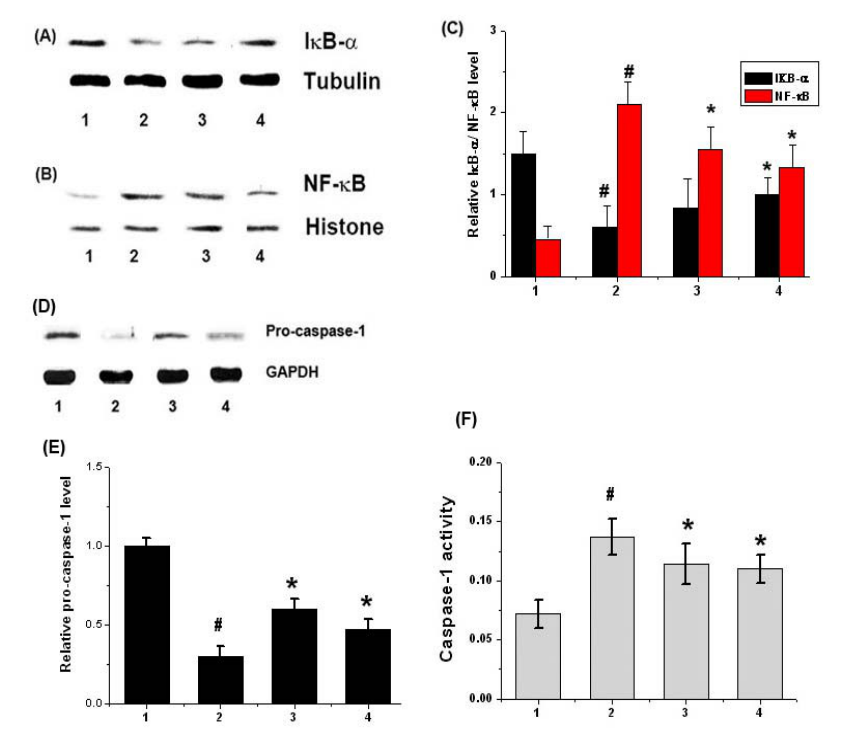
Figure 5. Effect of chrysophanol on degradation of I κ B- α and activation of NF- κ B and caspase-1 in LPS-stimulated murine peritoneal macrophages. (A) Cells (5 × 10 6 ) were pretreated for 1 h with chrysophanol (2 and 20 μ M) and then treated for 1 h with LPS (1 μ g/mL). The cytosolic extracts were prepared as described in the Experimental section and evaluated for I κ B- α by Western blot analysis; (B) Nuclear extracts were prepared as described in the Experimental section and evaluated for RelA/p65 by Western blot analysis; (C) The relative expression levels of I κ B- α / RelA/p65 were measured using an image analyzer; (D) The cells were pretreated with chrysophanol (2 and 20 µM) for 1 h prior to LPS stimulation for 12 h. The levels of pro-caspase-1 were assayed by Western blot analysis; (E) The relative expression levels of pro-caspase-1 were represented; (F) The enzymatic activity of caspase-1 was evaluated using a caspase colorimetric